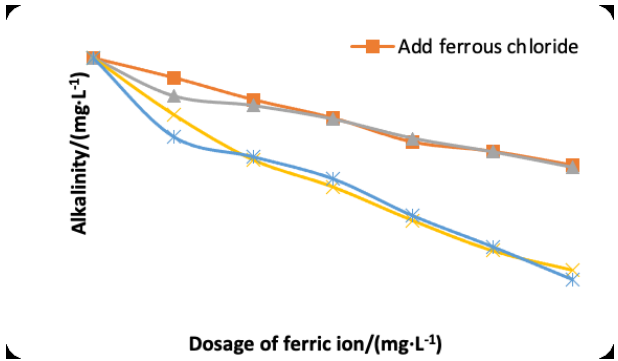
Fig. 2 Effect of adding ferric salt on alkalinity.